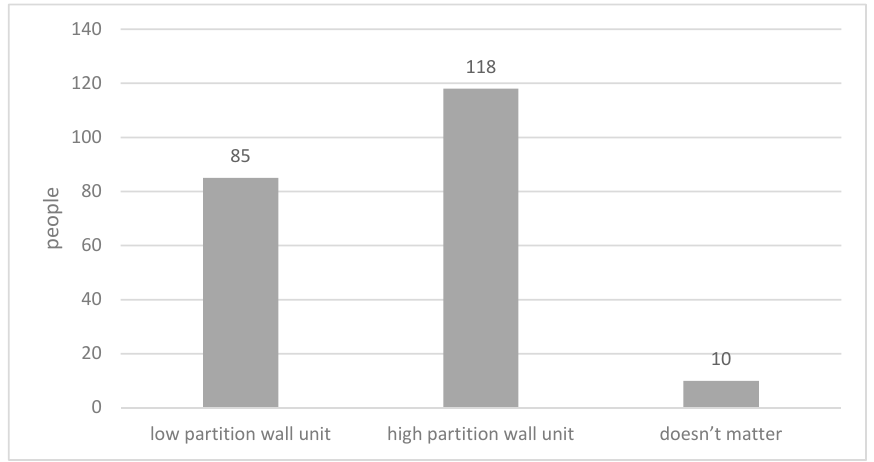
Figure 9. Preferred partition walls.